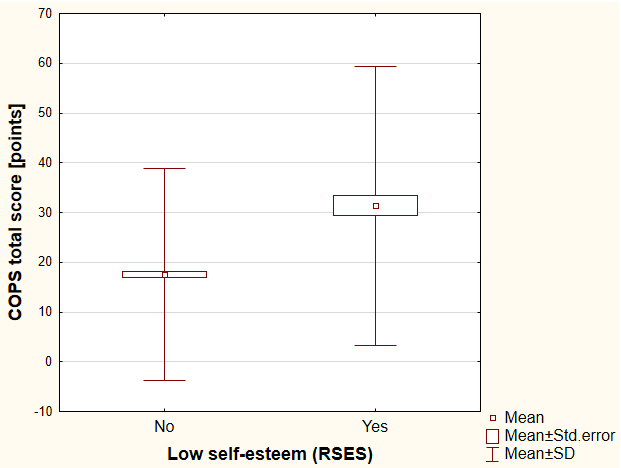
Figure 3. The differences in COPS total score between individuals with low self-esteem versus high self-esteem. COPS — the Cosmetic Procedure Screening Questionnaire, RSES — the Rosenberg Self Esteem Scale, SD — standard deviation.